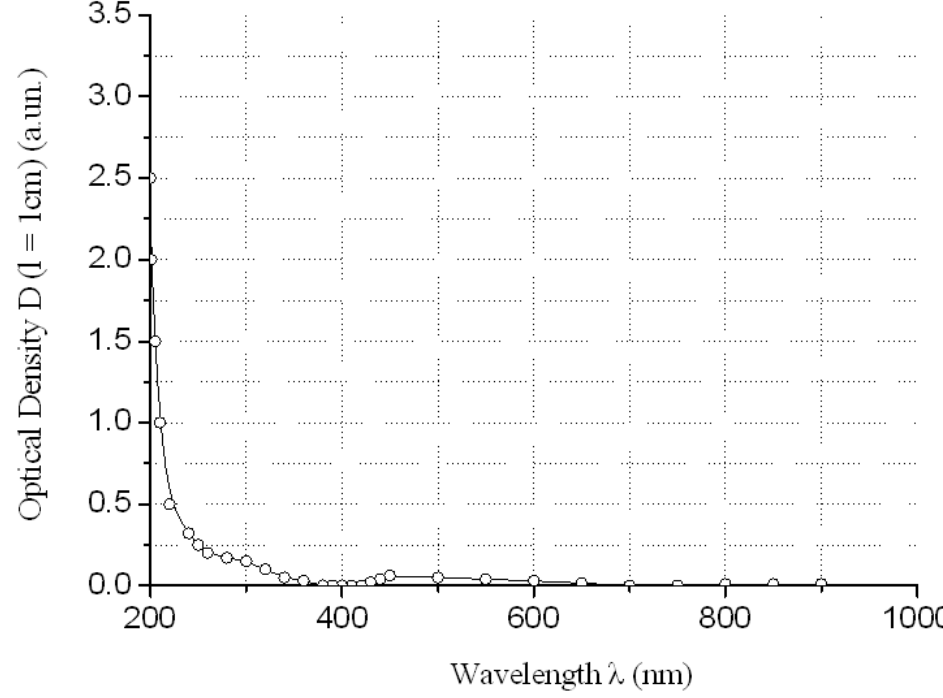
Figure 6. Electronic spectrum of water solution of YCl 3 at concentration C YCl3 ≈ 24.9 g/dm 3 relatively distilled H 2 O.